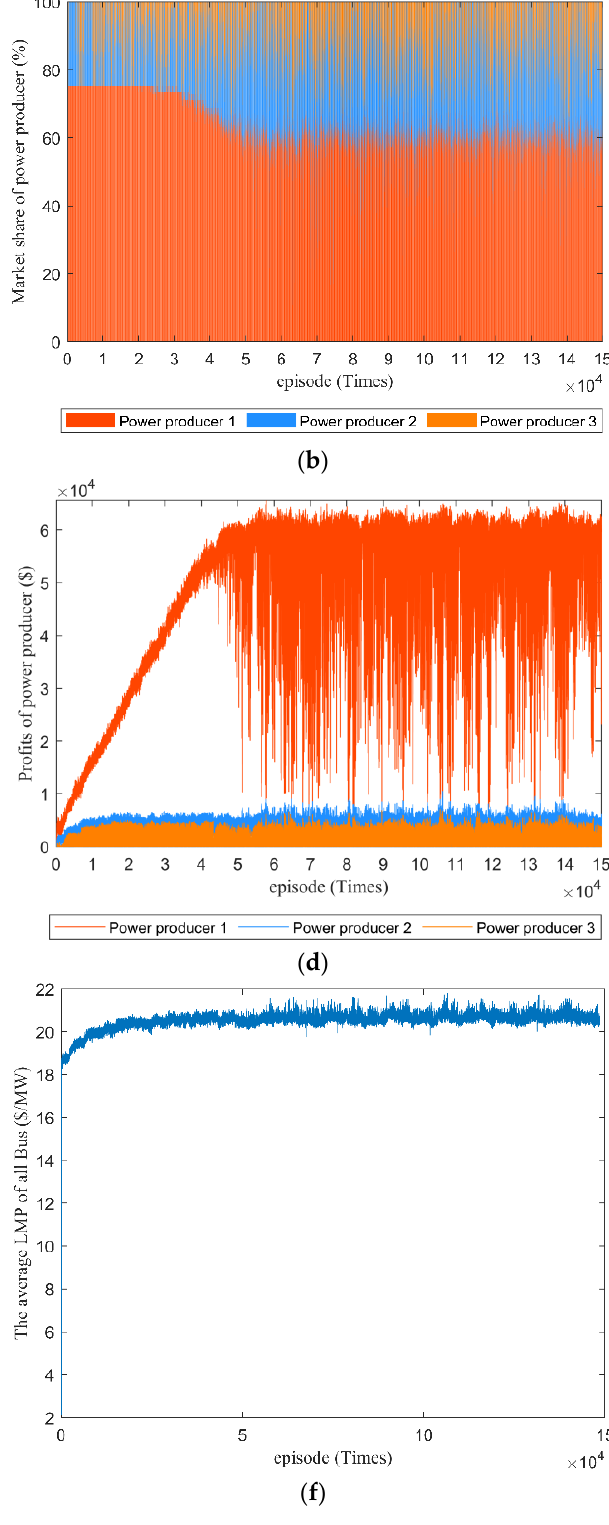
Figure 5. ( a ). The market share of all power producers in Scenario 1. ( b ). The market share of all power producers in Scenario 2. ( c ). The profits of all power producers in Scenario 1. ( d ). The profits of all power producers in Scenario 2. ( e ). The average LMP of all buses in Scenario 1. ( f ). The average LMP of all buses in Scenario